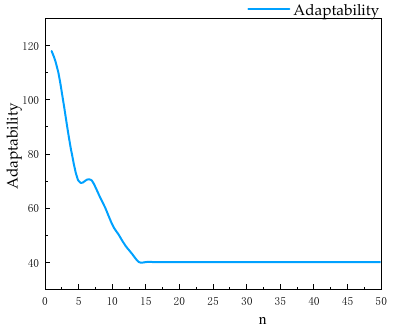
Figure 6. Convergence curve of GRNN structure optimized by CFA.